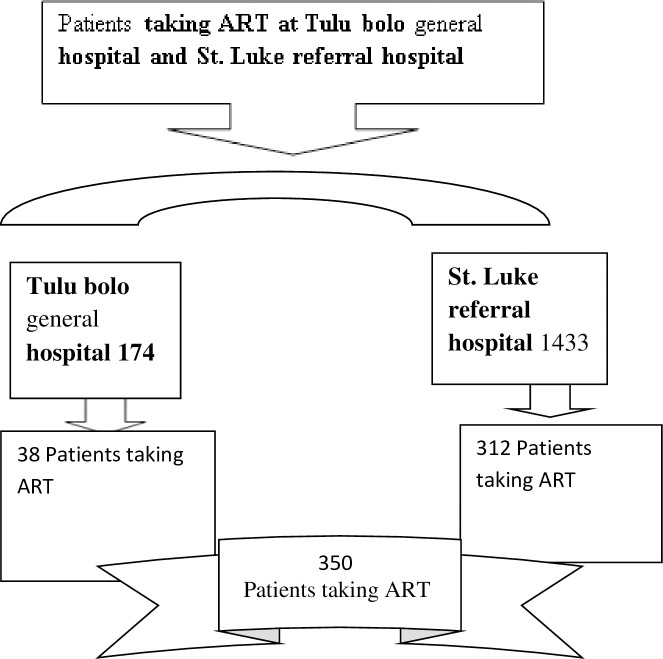
Schematic presentation of proportional allocation of patients taking ART at public health facilities in South West Shoa Zone, 2019.